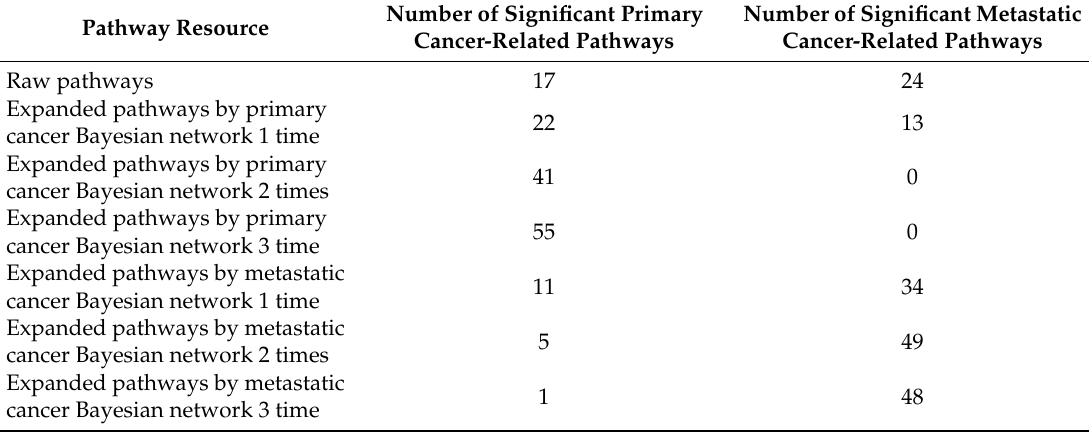
Table 1. Number of significant KEGG pathways using di ff erent pathway